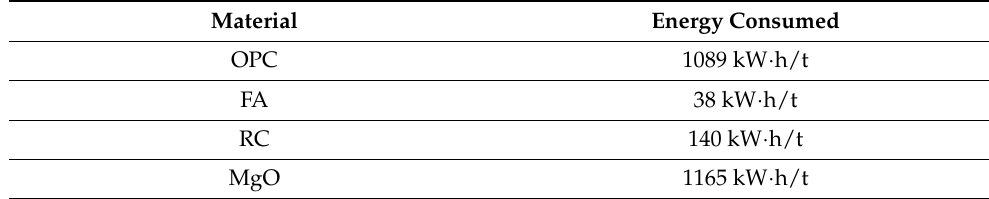
Table 10. Values used to calculate the energy consumed.